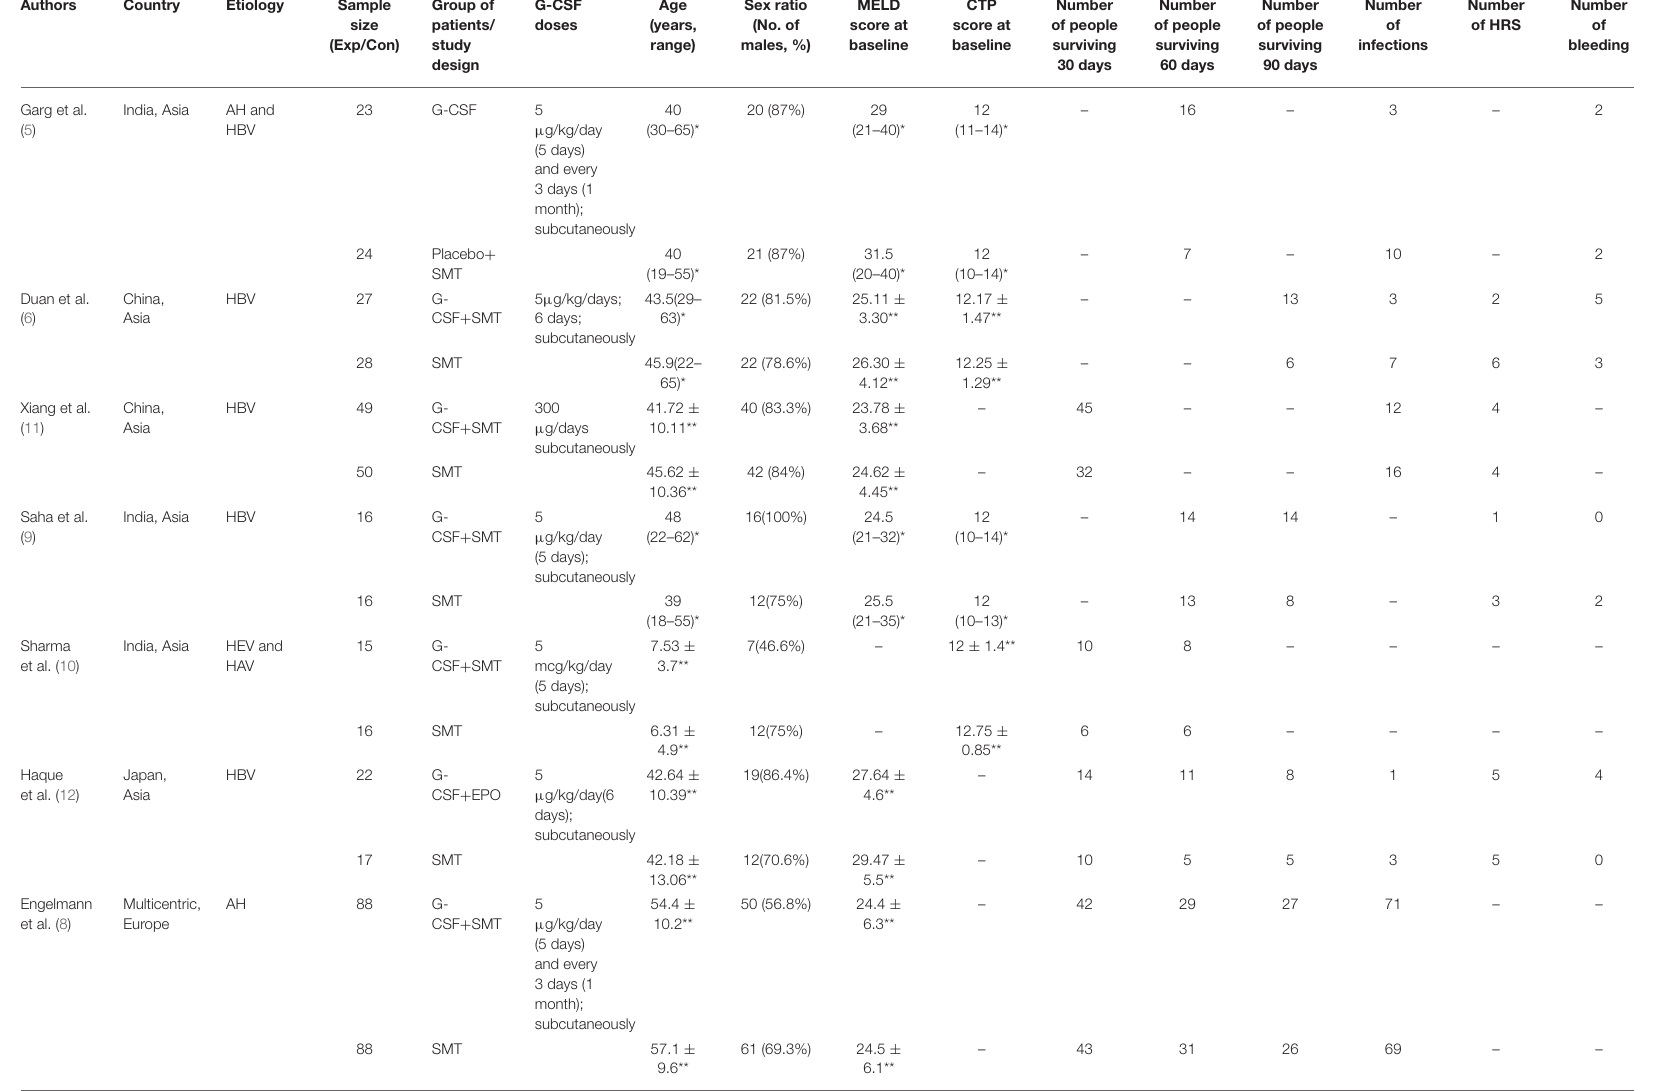
TABLE 1 | Basic characteristics of included